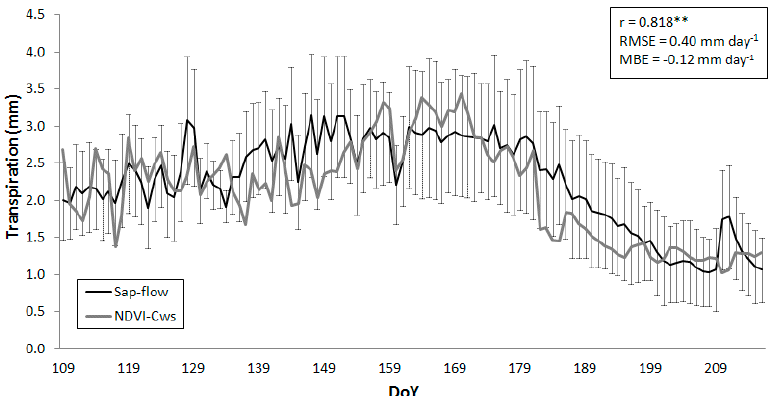
Figure 6. Daily olive tree transpiration measured by sap-flow (average and standard error from the four sampled trees) and estimated by the NDVI-Cws method driven by the olive tree NDVI endmembers. Data are collected, from 19 April to 8 August 2013 (** = highly significant correlation, p < 0.01).